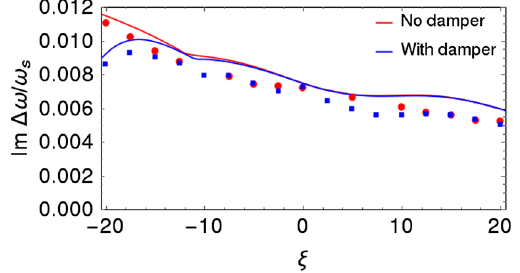
FIG. 6. NHT solution (solid lines) agrees with the average growth rates found in a multibunch particle tracking simulation in P y HEADTAIL (dots). The growth rate created by a single crab cavity HOM varies only slightly with chromaticity and is weakly affected by the presence of a transverse damper. R equidistant bunches of 2 . 3 × 10 11